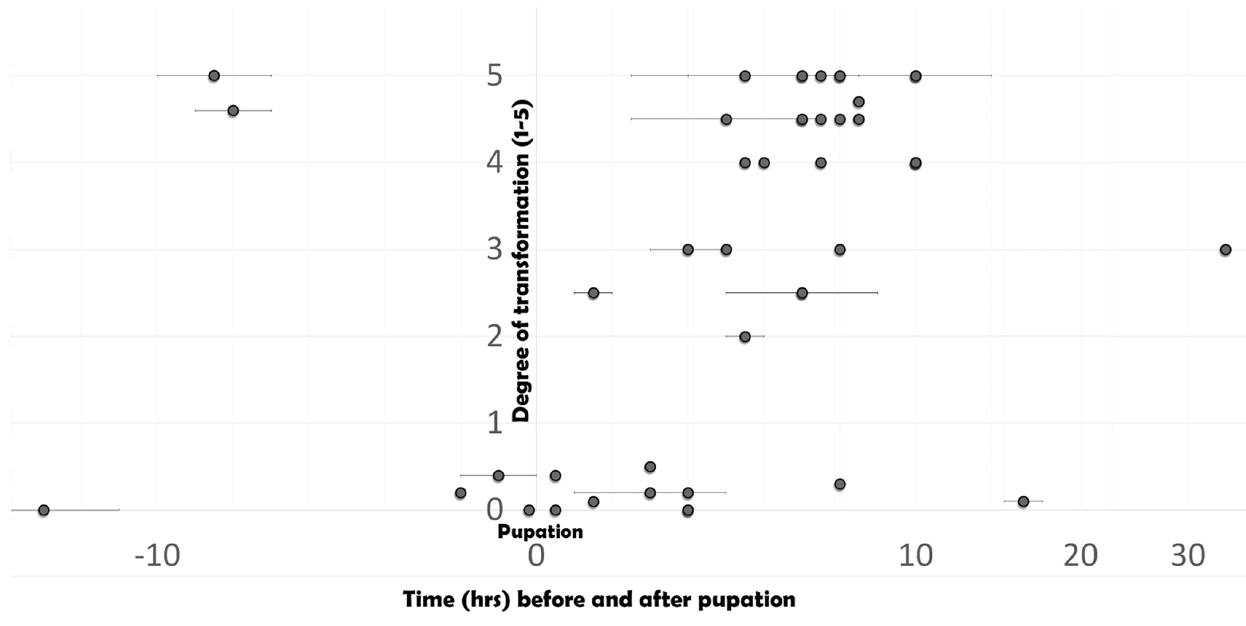
Figure 5. The monarch, Danaus plexippus . Degree of transformation (as determined by a blind score assignment) in relation to the time before or after pupation. See Extended Data (Sourakov, 2020) for injection